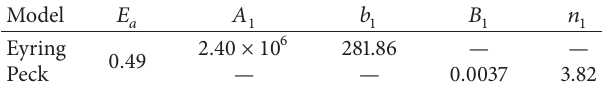
Figure 5: AF Contours of module temperature and rh eff for two 𝑅 𝐷 prediction models: (a) Eyring model, (b) Peck model. Table 2: Activation energy and constants of Type 1 samples for Eyring and Peck